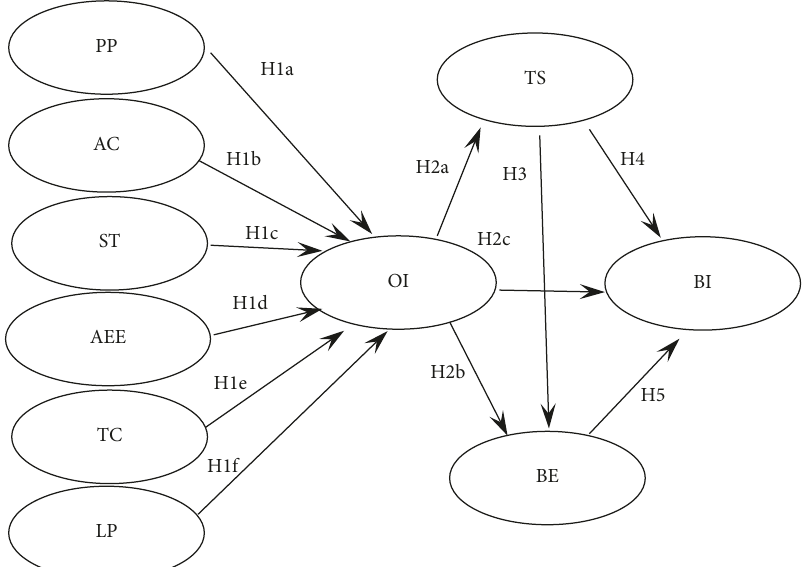
Figure 1: Theoretical model. Note . Potential variables in the set model are represented by corresponding English letters to save space. Among them, PP represents performance; AC represents accessibility; ST represents self-service technology; AE represents aesthetic environment; TC represents tourist community; LP represents loyalty program; OI represents overall innovation; TS represents tourist satisfaction; BE represents brand equity; and BI represents behavioral intentions. In Figures 2 and 3 as follows, the latent variables are also represented by the corresponding English letters, whose meanings are completely consistent with the set theoretical